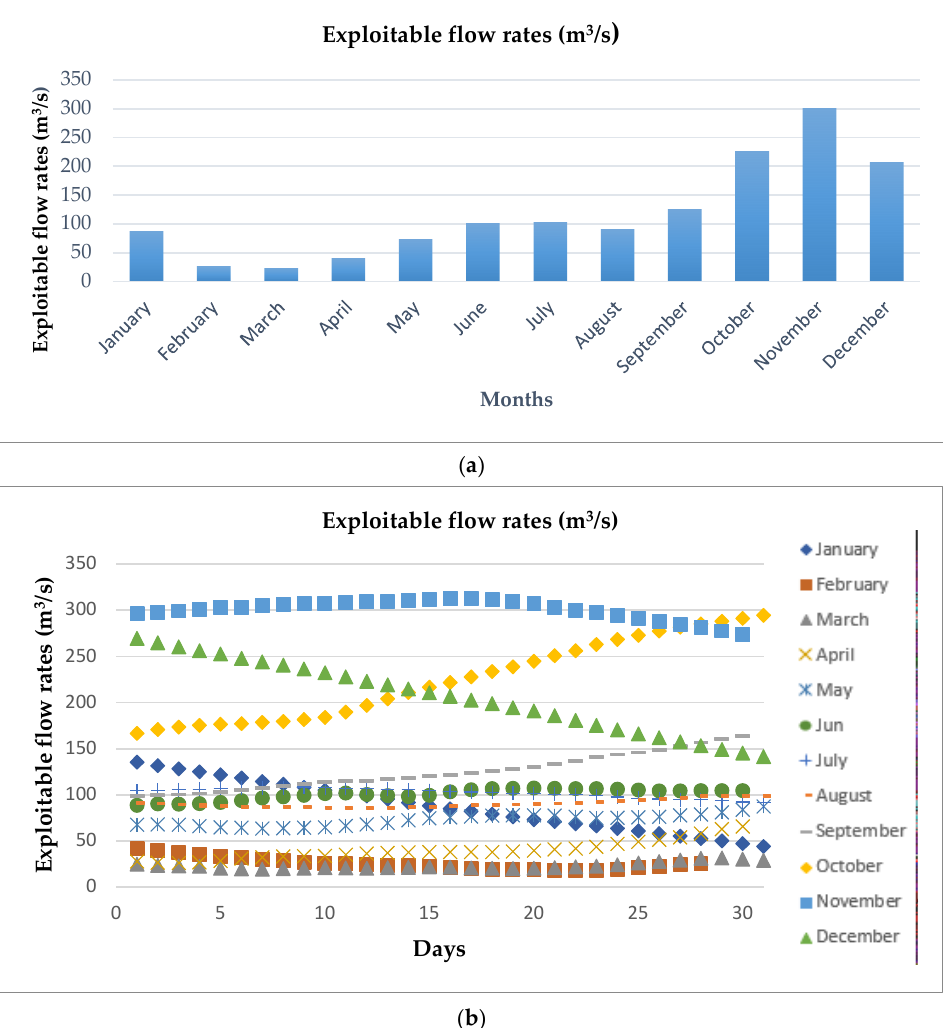
Figure 8. ( a ) Average monthly exploitable flow rates histogram and ( b ) average daily exploitable flow rates